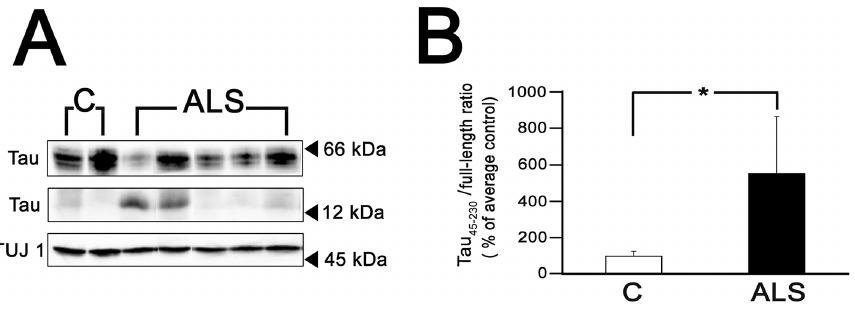
was also detected in the precentral gyrus of ALS subjects. (A) Quantita- Figure 2. Tau 45-230 tive Western blot analysis of tau content in representative homogenates prepared from postmortem samples of precentral gyrus from control (C) and ALS (ALS) subjects. Immu- noreactive bands at 17 kDa apparent molecular weight corresponding to tau readily detectable in some ALS samples. (B) Graphs show the ratios of tau tau in control and ALS subjects. Numbers represent the mean ± SEM of control (n = 9) and ALS tau positive (n = 10) samples. Values are expressed as percentage of controls, 45-230 considering the values obtained in control subjects as 100%. ALS Class III β tubulin (TUJ1) was used as loading control. *Differs from control subjects; P < 0.01.